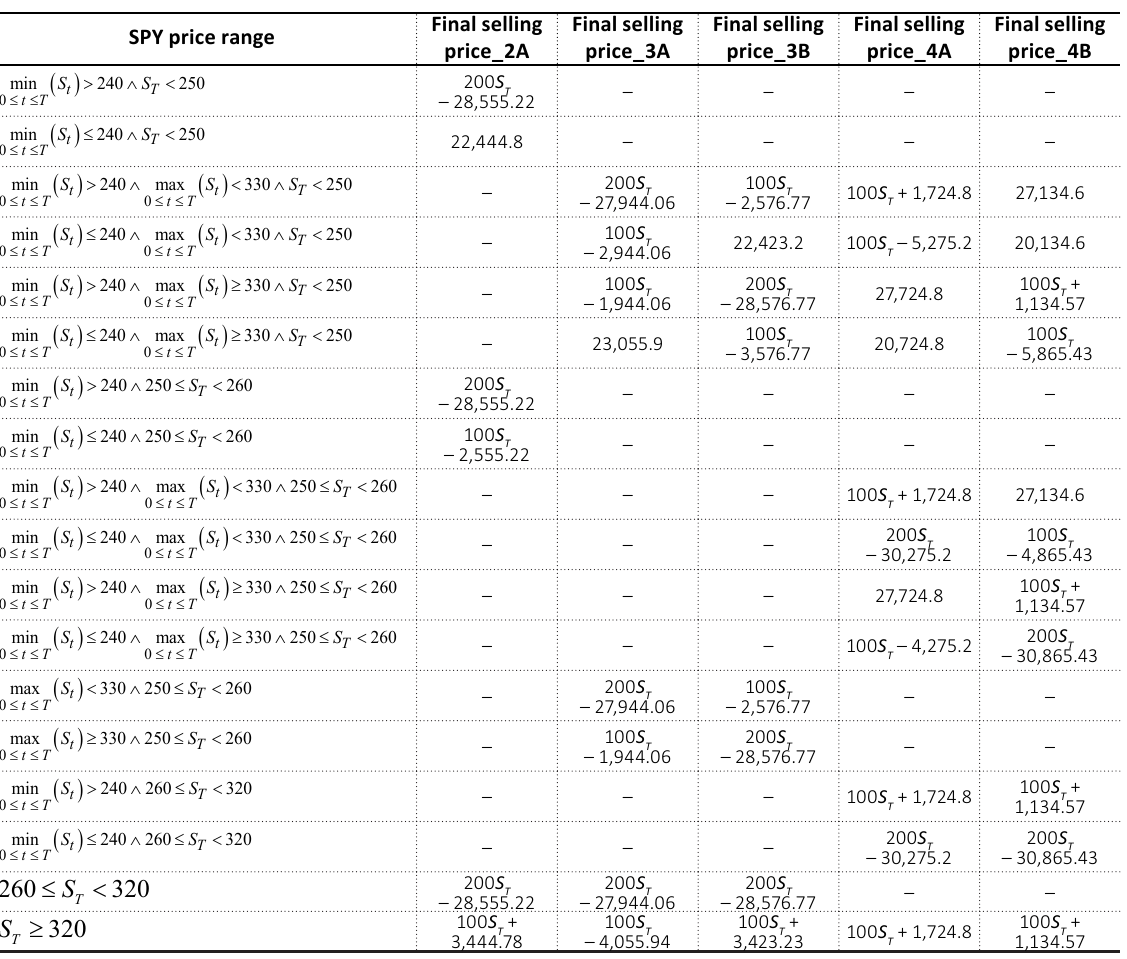
Table 10. Comparison of the hedging techniques 2A, 3A – 3B and 4A – 4B